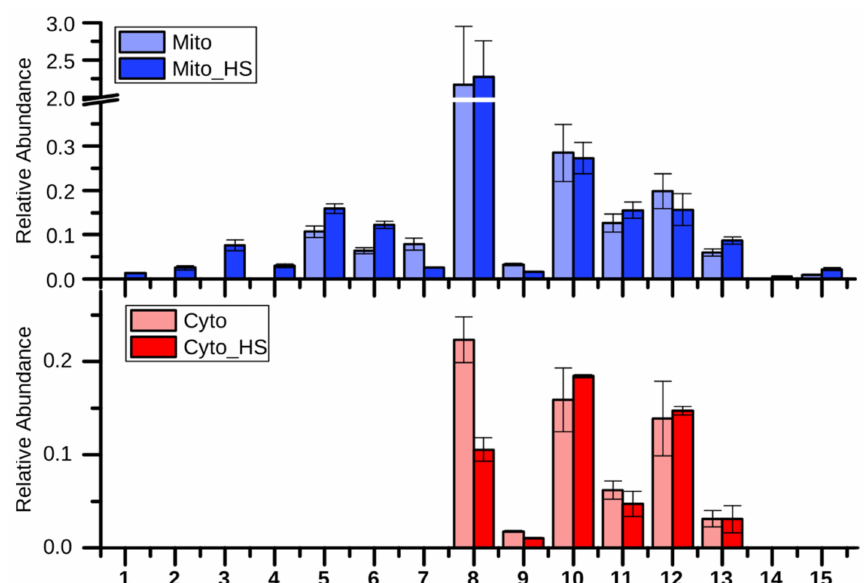
Figure 2. Relative abundance of the detected metabolites of lipid metabolism (mean +/ - standard derivation of technical triplicate, applied also to other bar charts). 1 . Ergosta-7-en-3-ol; 2